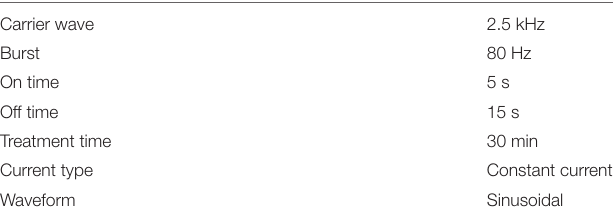
TABLE 2 | Parameters for active electrical